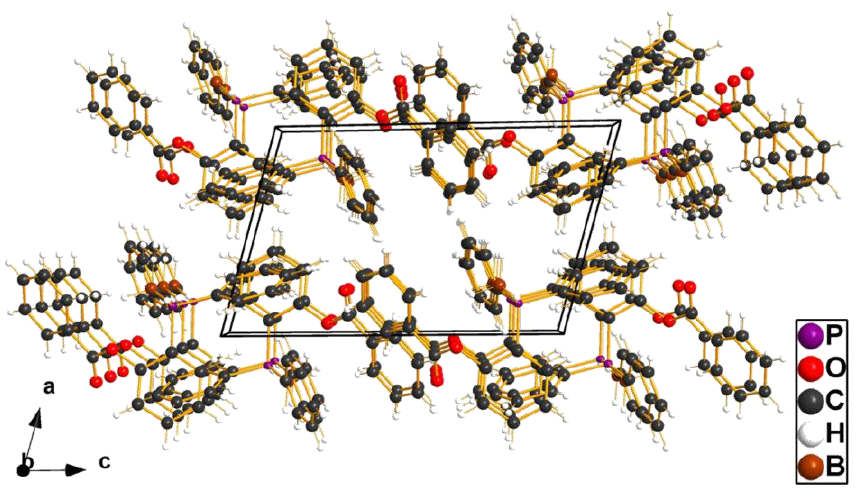
Figure 2. View of the packing of molecules in crystals of 4 along the crystallographic b